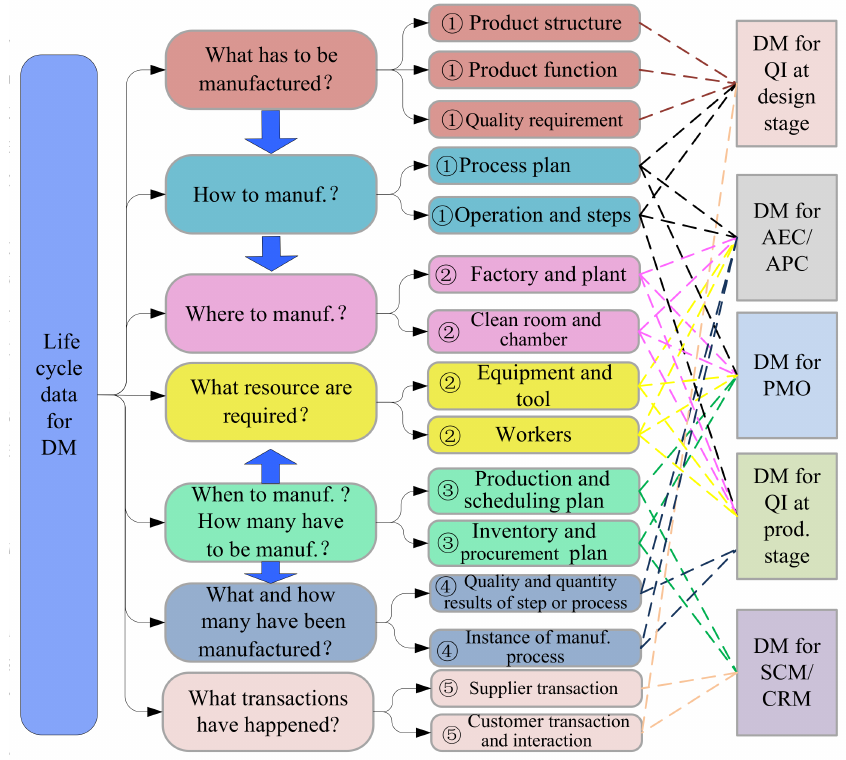
Figure 9. The data content for different knowledge